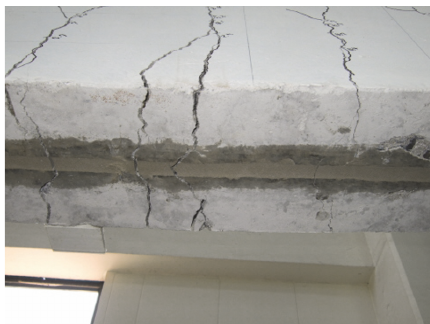
Figure 6: Rupture of CFRP tendon (SL90-E-40).